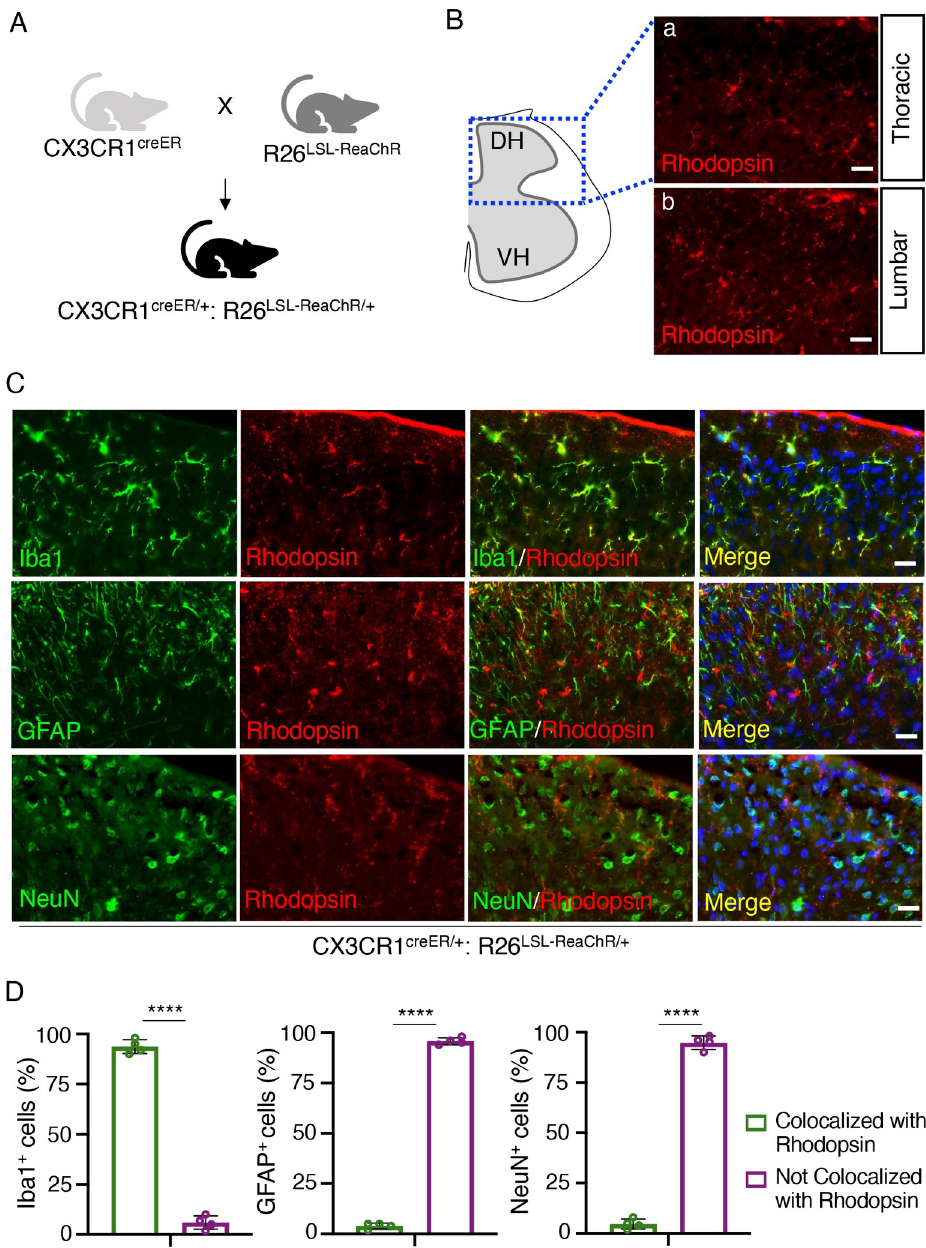
Fig 1. CX3CR1 creER/+ : R26 LSL-ReaChR/+ transgenic mice enable selective expression of ReaChR in spinal microglia. (A) Generation of CX3CR1 creER/+ : R26 LSL-ReaChR/+ transgenic mice by crossing CX3CR1 creER/creER mice with R26 LSL-ReaChR mice. (B) Immunofluorescence images indicate rhodopsin expression in the thoracic and lumbar sections of the spinal cord. Scale bar, 40 μ m. (C) Representative images of rhodopsin immunostaining (red) with either Iba1 (green), GFAP (green), or NeuN (green) in the lumbar region of the spinal dorsal horn in CX3CR1 creER/+ : R26 LSL-ReaChR/+ mice after TM injection. Scale bar, 40 μ m. n = 4 mice/group. (D) Summarized data show the co- localization of rhodopsin with Iba1 + cells but not with GFAP + or NeuN + cells. Data are presented as mean ± SEM. n = 4 mice/group, ���� P < 0.0001, unpaired Student t test. For data plotted in graphs, see S1 Data. ReaChR, red- activated channelrhodopsin; TM, tamoxifen.